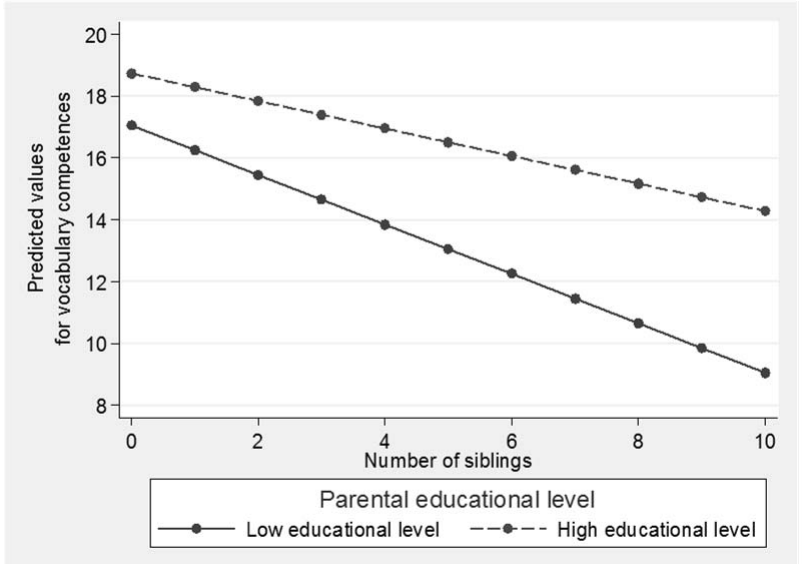
Figure 1 : Interaction effect of number of siblings and families’ educational